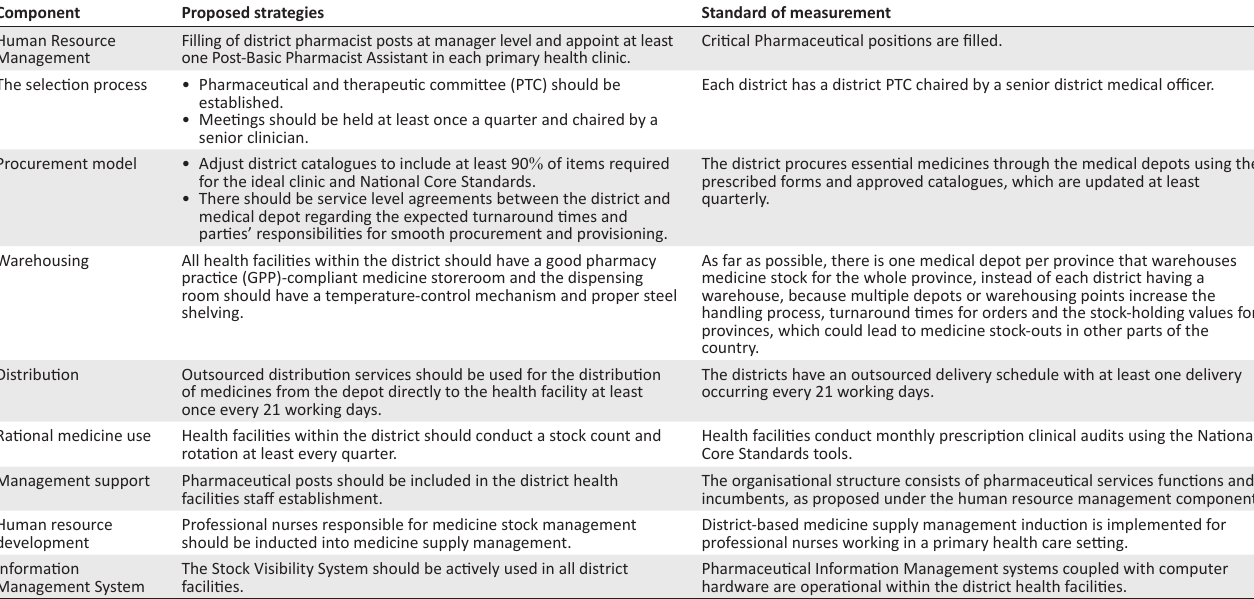
TABLE 1: Proposed strategies to improve the provisioning of essential medicines.